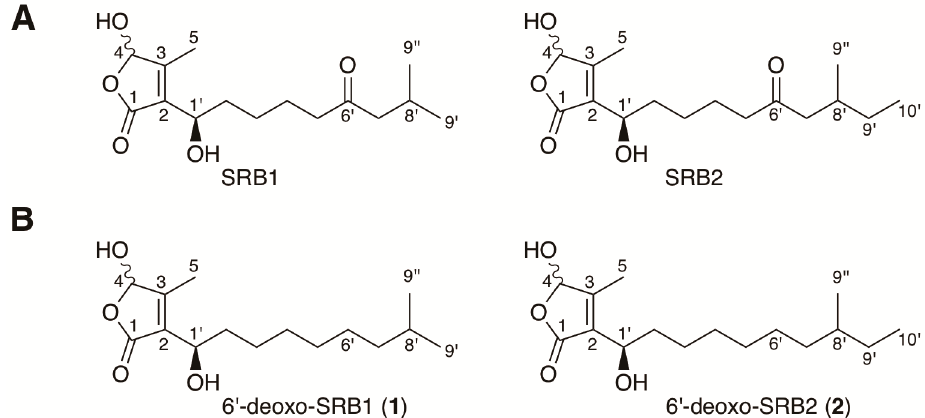
Figure 1. Structures of Streptomyces rochei signaling molecules. ( A ) natural signaling molecules SRB1 and SRB2 isolated from S. rochei 7434AN4; ( B ) 6 ′ -deoxo-SRB1 ( 1 ) and 6 ′ -deoxo-SRB2 ( 2 ) isolated from the srrO mutant (strain KA54) of S. rochei.